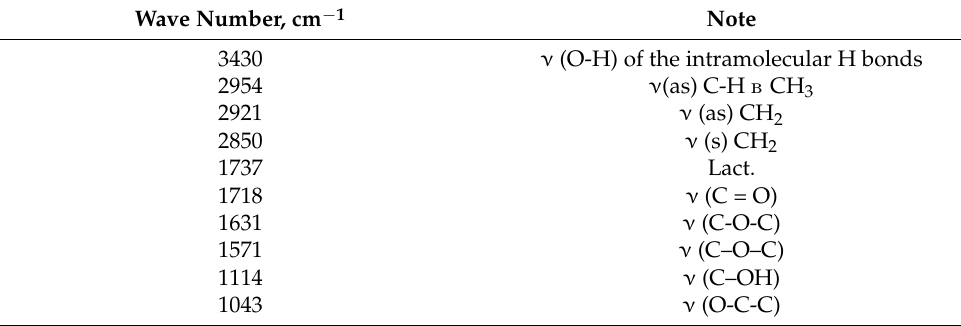
Table 5. IR characteristics of ginkgolide B.